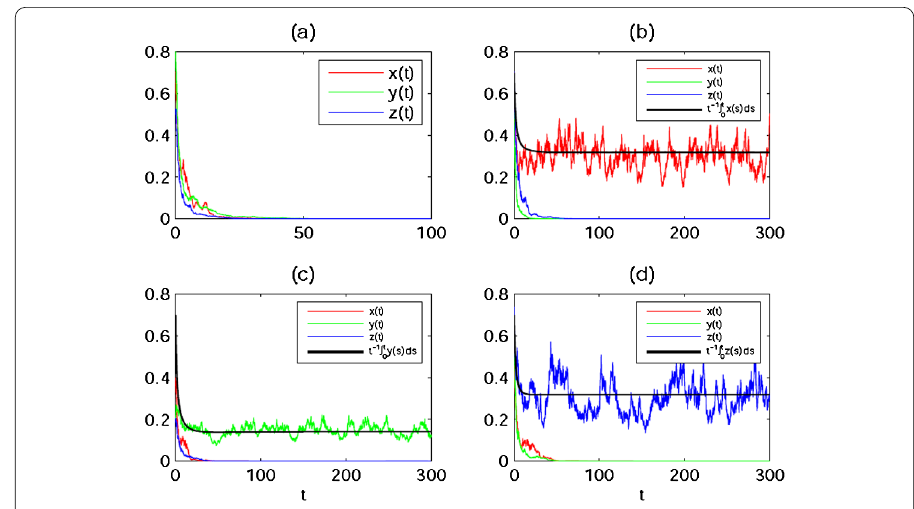
Figure 1 (a) Let α 1 = 1.1, α 2 = 0.8 and α 3 = 1 such that r i < α 2 /2, i = 1,2,3. It follows from Theorem 2.2 that i all the species of model (1.2) go to extinction a.s. (b) Let α 1 = 0.7, α 2 = 1 and α 3 = 0.85 such that r 1 > α 2 1 /2, ρ 2 < ˜ ρ 2 , and G 3 < ˜ G 3 ((i) of Theorem 2.3). Then the species y ( t ) and z ( t ) go to extinction a.s. and x ( t )